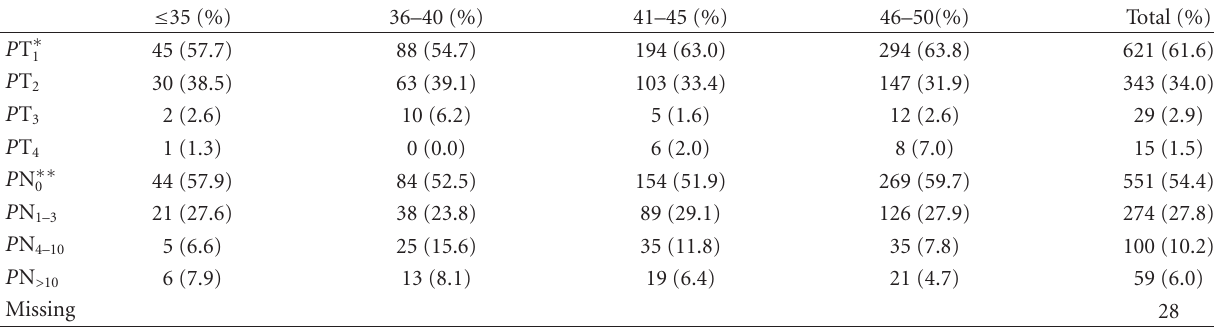
Table 3: TN stage according to age groups— n